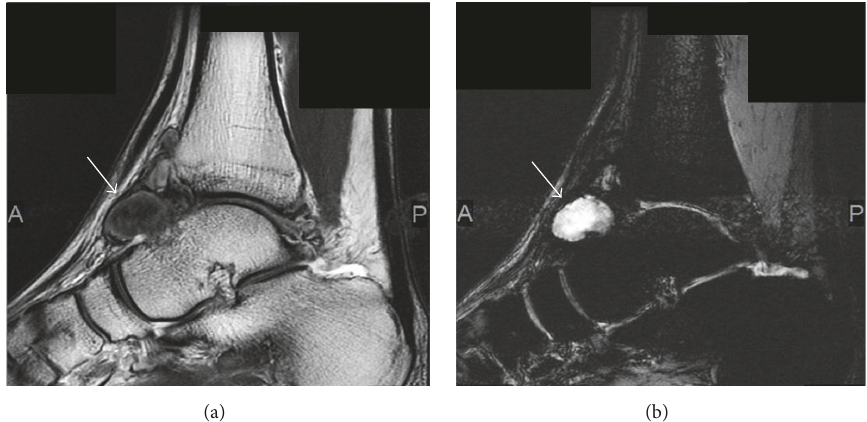
Figure 5: Magnetic resonance images showing a pseudoaneurysm 25 × 22 × 13 mm in size arising from the anterior tibial artery (arrow) at the level of the ankle joint. The pseudoaneurysm is seen as a mass with a heterogeneous (a) low-intensity to isointensity signal on T2-weighted imaging and (b) high-intensity signal on T2 star-weighted imaging.